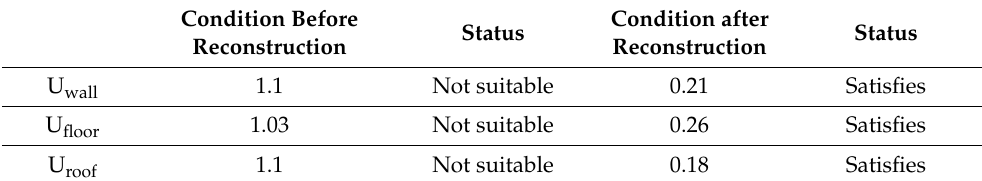
Table 7. Determined heat transfer coefficients for given building blocks.